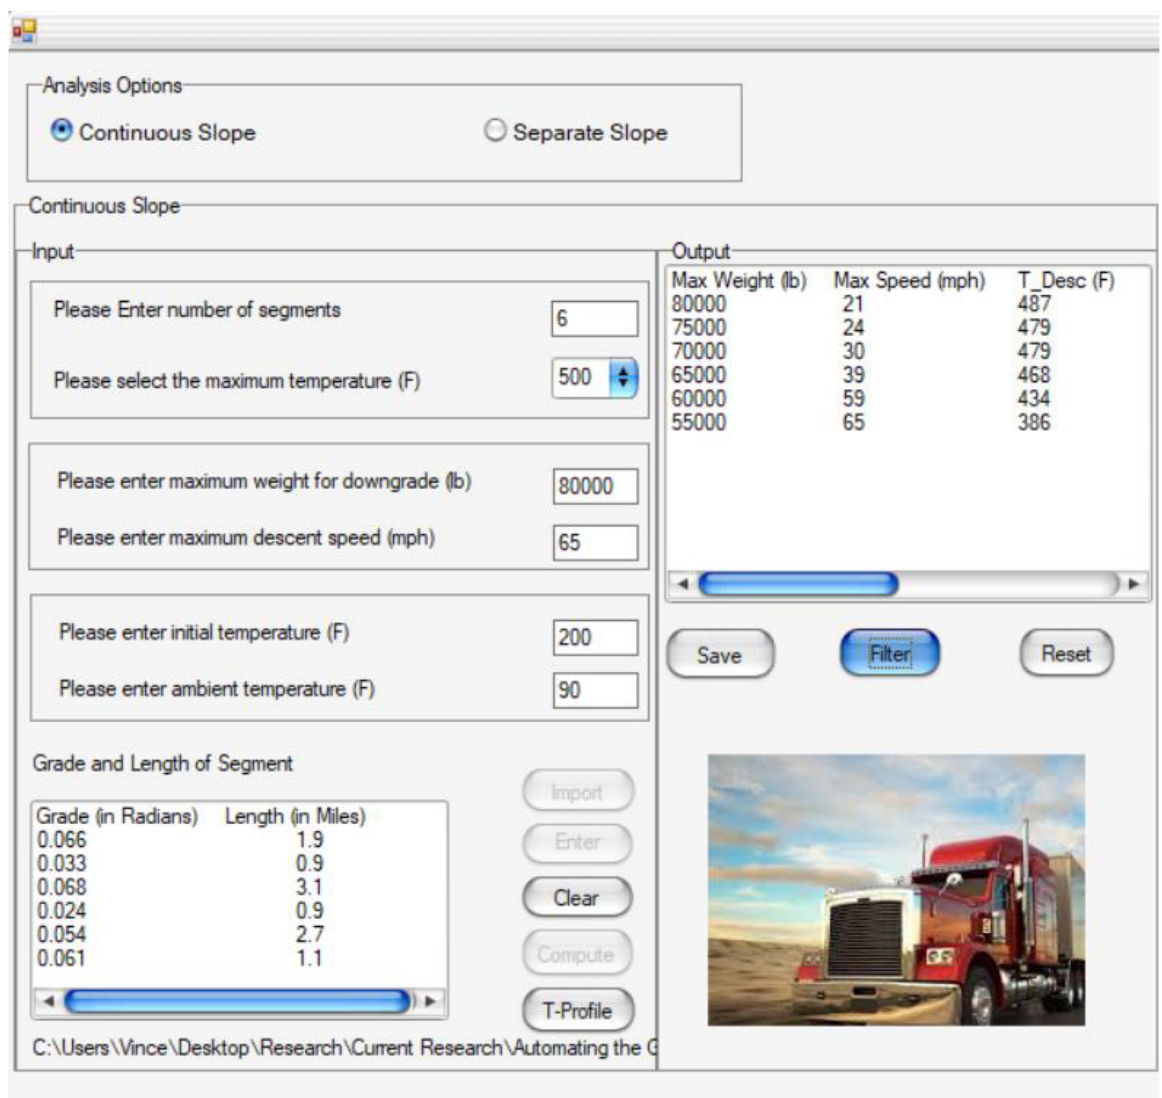
Figure 4: Continuous slope analysis option of the